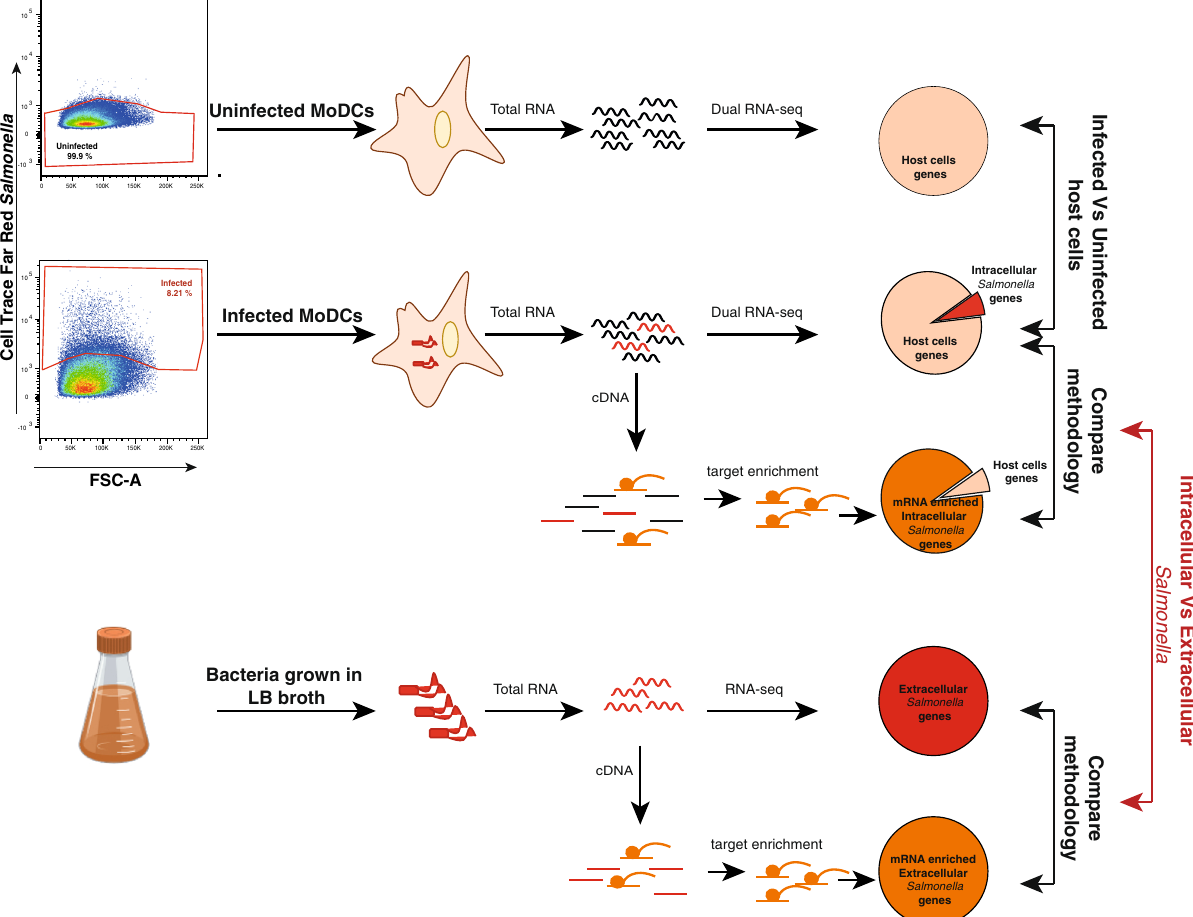
Fig. 1 Dual RNA seq of human MoDCs challenged with invasive or non-invasive Salmonella . Schematic representation of the experimental design. Human MoDCs were challenged with labelled bacteria. At 6 h post infection, infected cells or uninfected cells were sorted and total RNA was extracted. Libraries were prepared according to the SMARTer stranded kit and human rRNA was depleted. Libraries were then hybridised with the Salmonella -speci fi c probes or left unenriched before sequencing. Libraries prepared from RNA extracted from bacteria grown in LB broth were used as